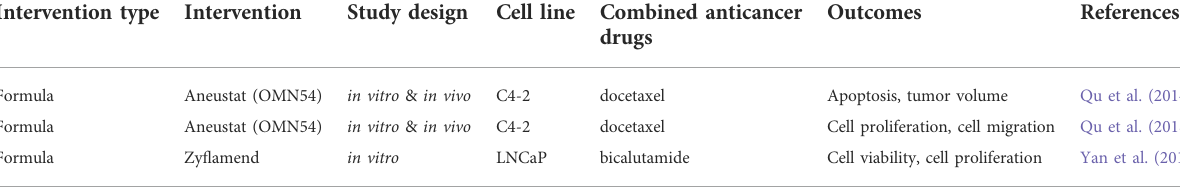
TABLE 4 Summary of studies using compound